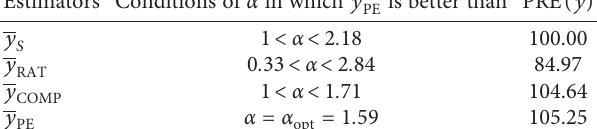
S and conditions is better than PRE ( y ) PE